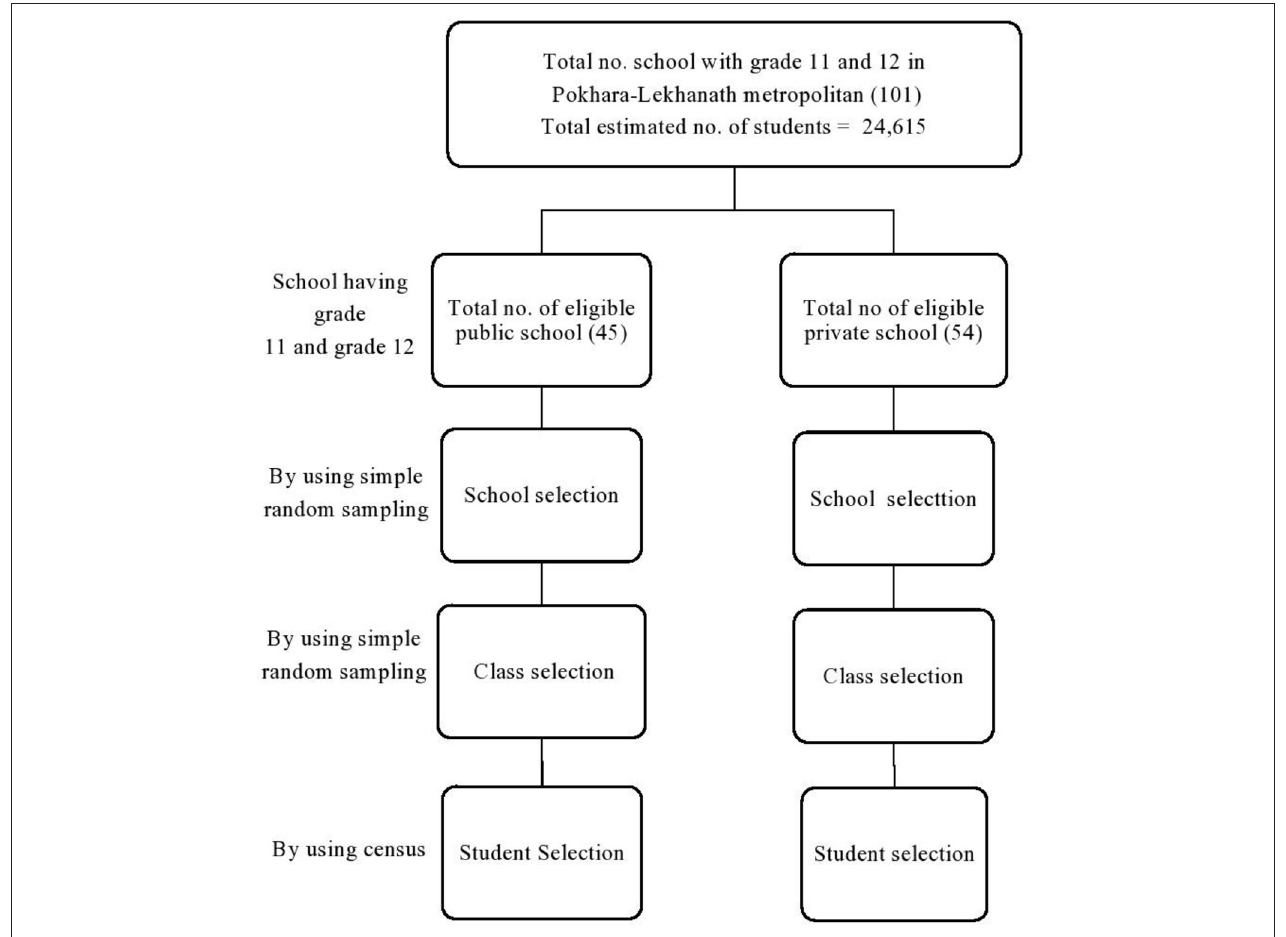
FIGURE 1 | Flow diagram of sampling